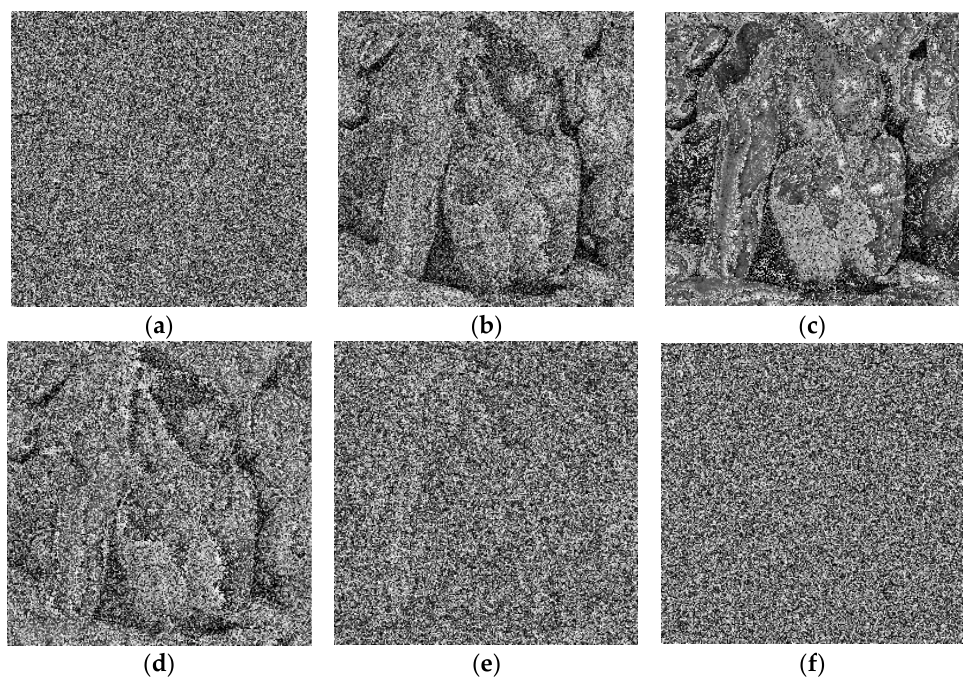
Figure 8. Peppers decryption diagram except for the bit-scrambling stage: ( a ) ours; and those algorithms proposed in ( b ) [1]; ( c ) [2]; ( d ) [4]; ( e ) [7]; and ( f ) [8].